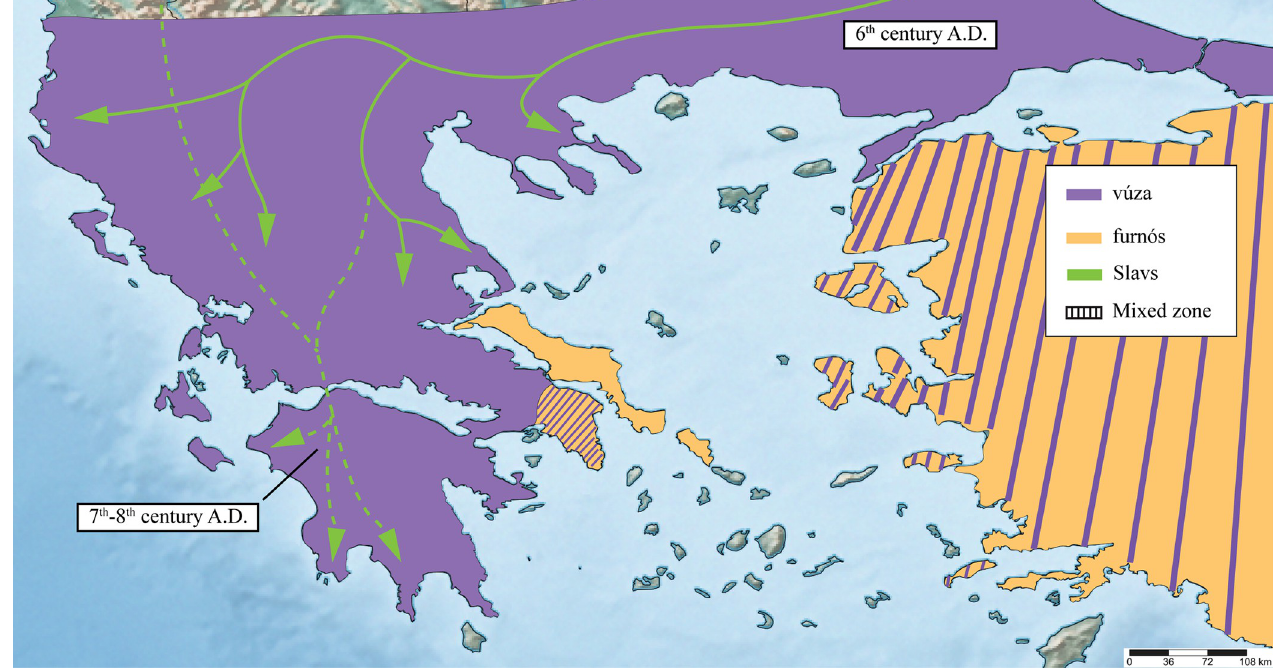
Fig 6. Hypothetical distribution of the zoonyms β ού z α ( vúza ) and φουρνό B ( furnós ) in the 6 th century AD, immediately prior to the Slavic migrations. The green arrows represent the waves of Slavic settlement according to [13, 77, 78]. The green dotted line indicates the uncertainty about the homeland of the Slavic populations that invaded the Peloponnese. The mixed orange-purple zones in Attica and Asia Minor are speculative, as the zoonyms used in those areas is not known.